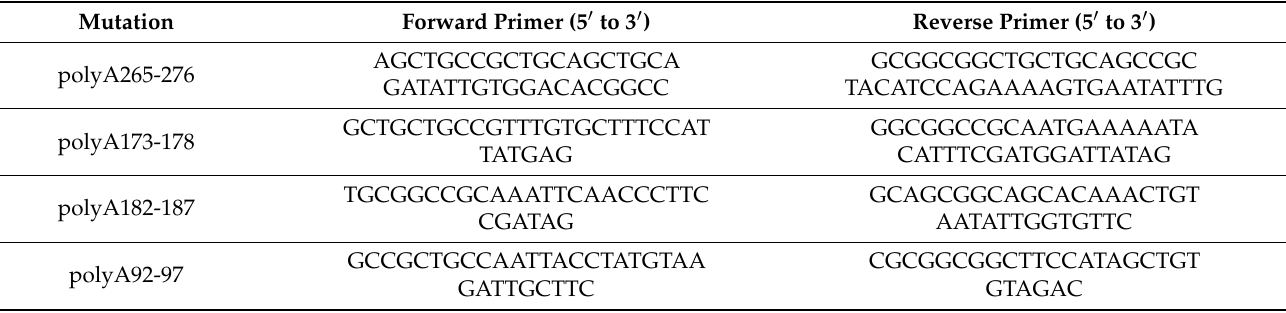
Table 1. Primer sequences for site-directed